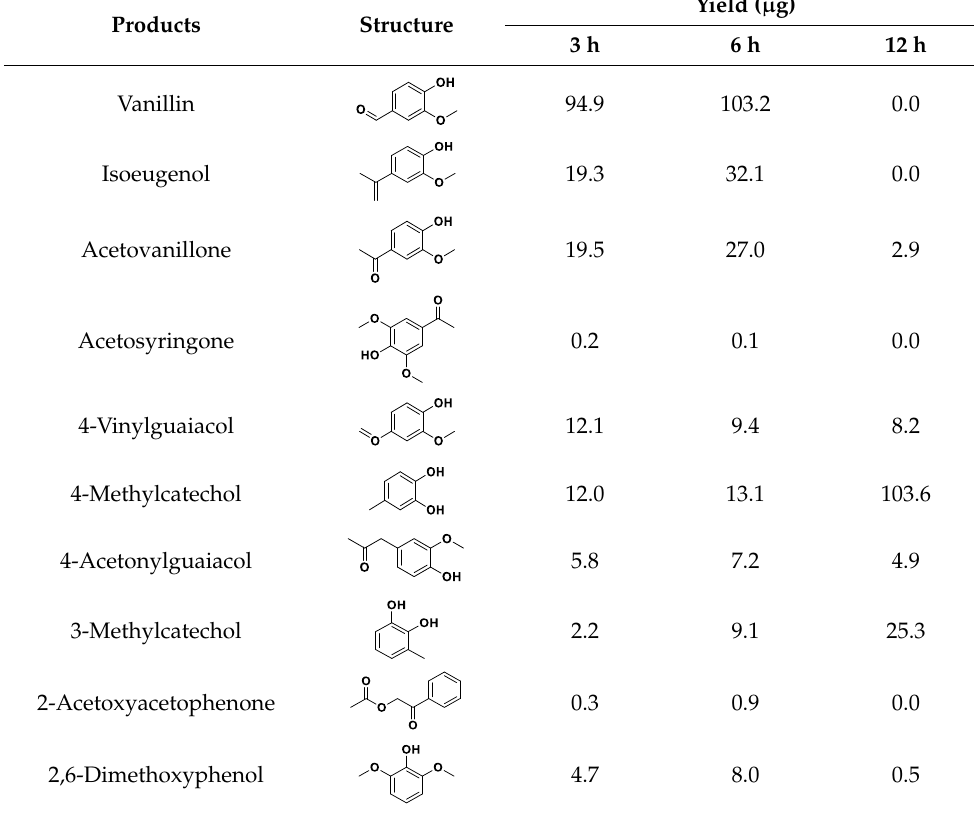
Table 4. The predominant products from the hydrogenolysis of lignin.